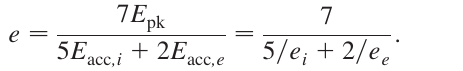
FIG. 10. (Color) e ¼ E for the half-cavity from Fig. 9.